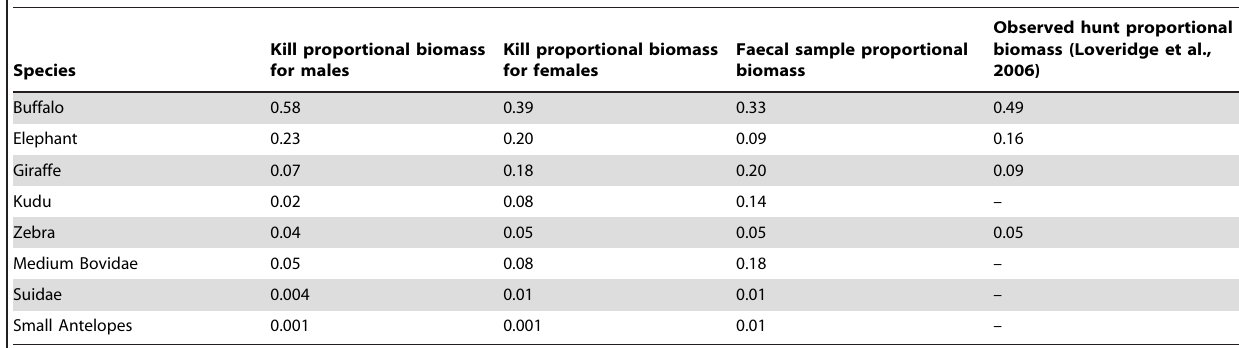
Table 3. Prey species proportional biomass contributing to lion diet, as detected from kills, faecal samples and observed hunts.